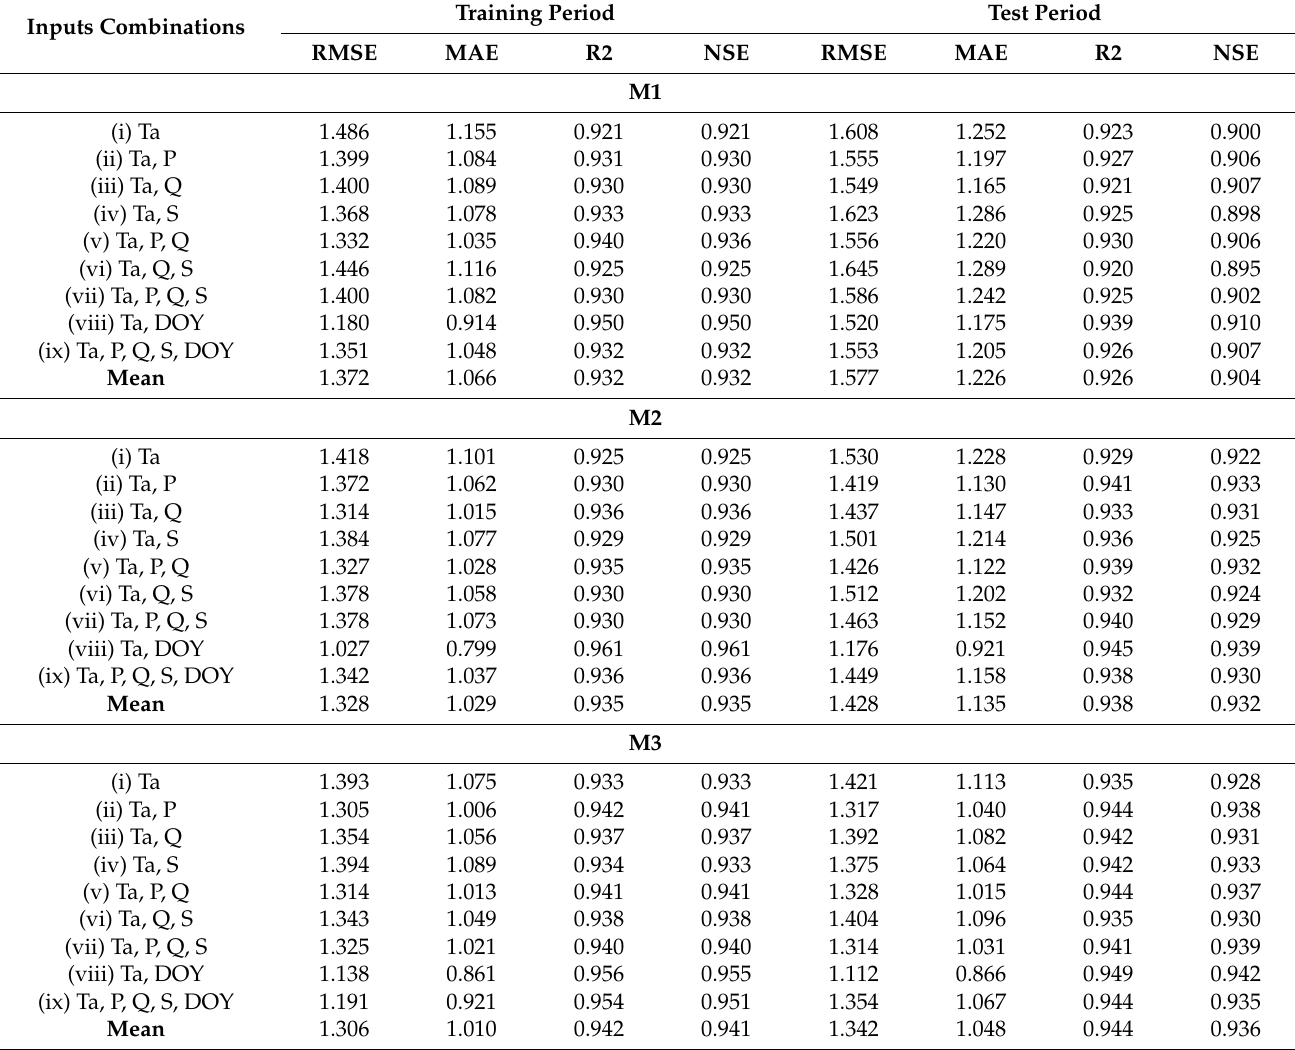
Table 8. Training and test statistics of the models for water temperature prediction—LSTM-RSA. Inputs